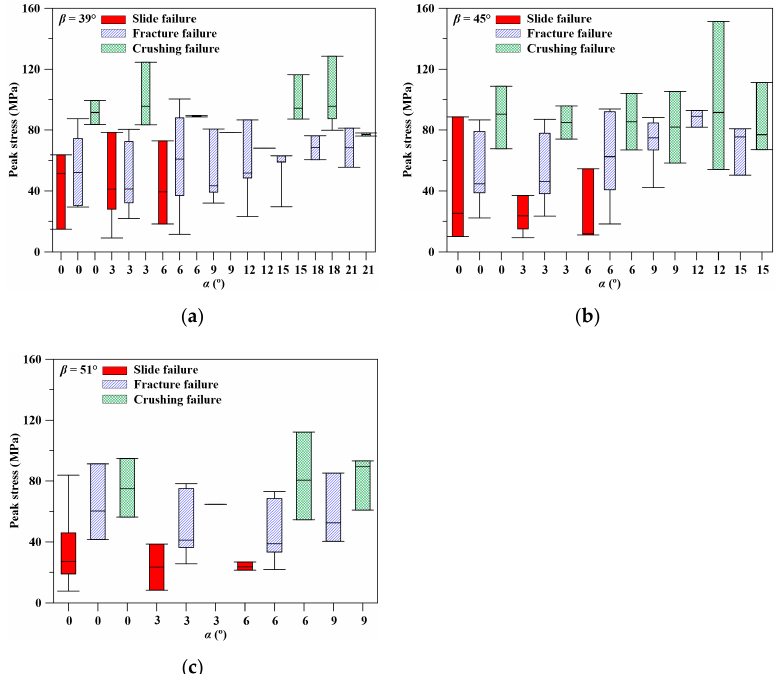
Figure 11. Box-and-whisker plot of dynamic peak stress at various angles, α , for specimens with β = 39 ◦ , 45 ◦ , and 51 ◦ ( a – c ). Appl. Sci. 2020 , 10 , x FOR PEER REVIEW